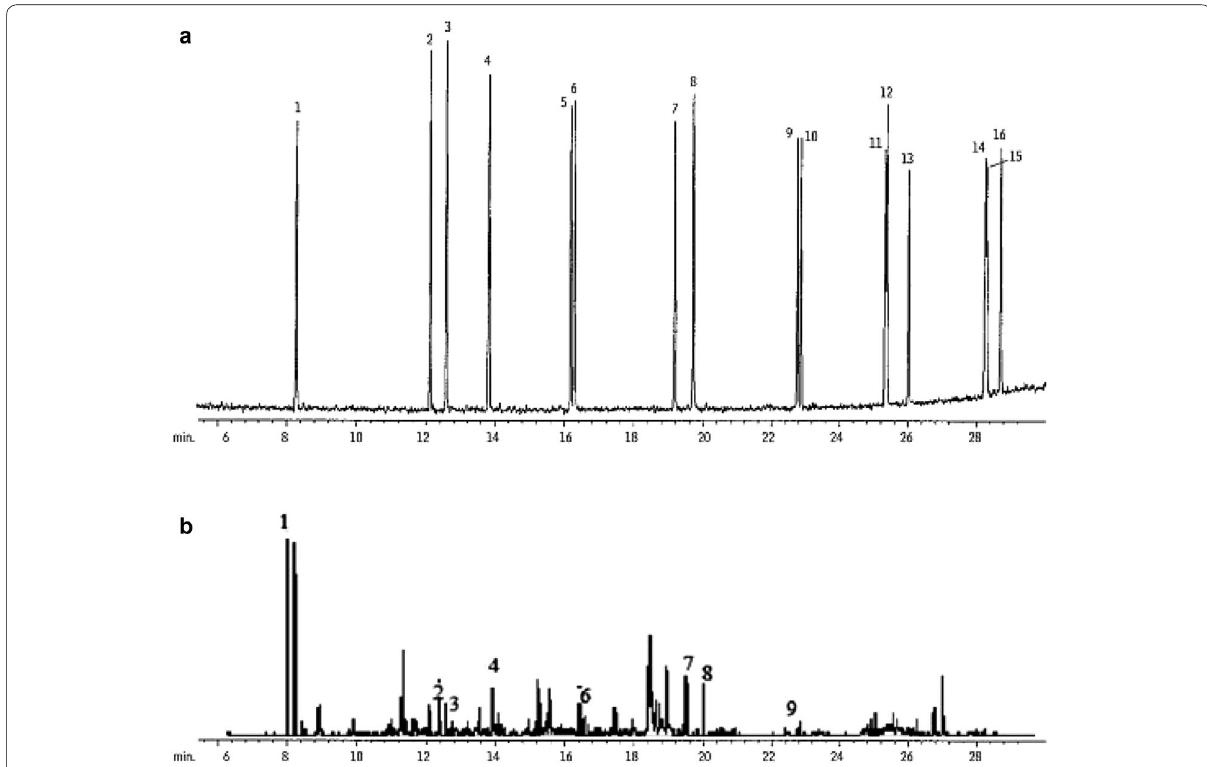
Fig. 4 HPLC chromatograms of PAHs mix solution by selected mycobacterial isolates, a control samples, b after 144 incubation at 30 °C. (1) Naph- thalene, (2) acenaphthylene, (3) acenaphthene, (4) fluorene, (5) phenanthrene, (6) anthracene, (7) fluoranthene, (8) pyrene, (9) benzo[a] anthracene,